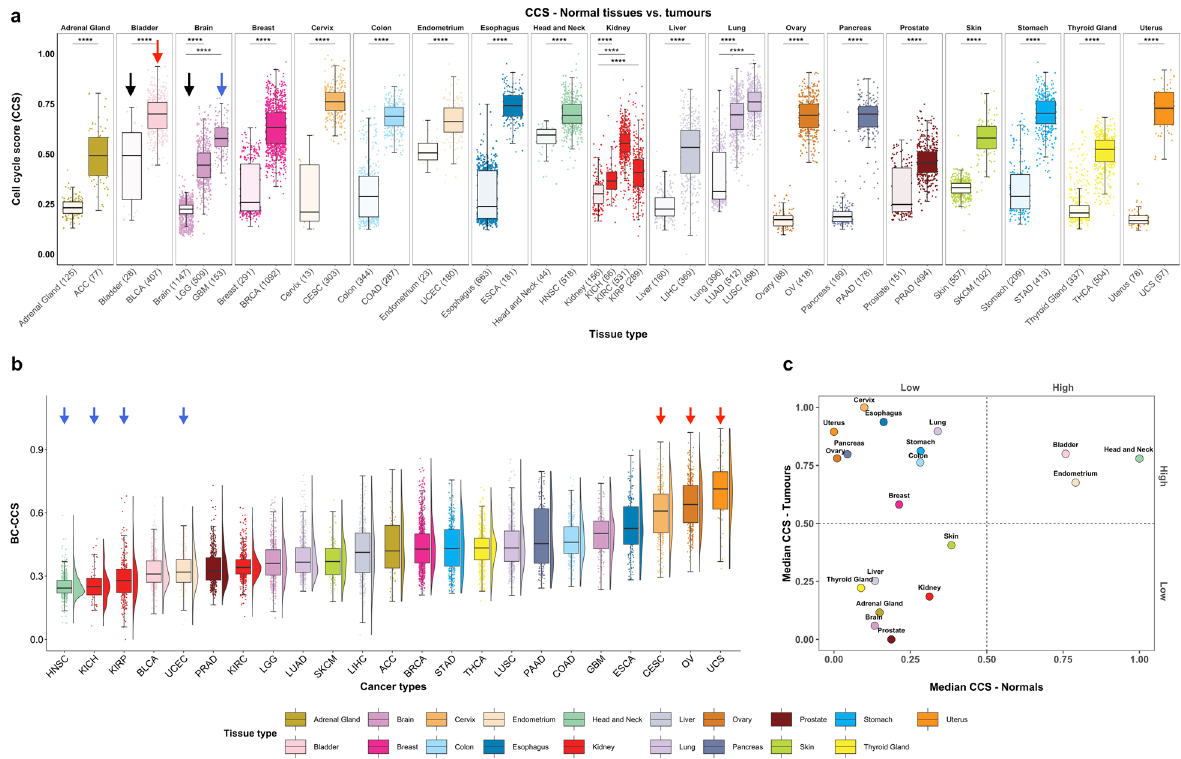
Fig. 3 Boxplots and scatterplot comparing cell cycle activity across normal tissue and Pan-Cancer Atlas tumour samples. Toil pipeline batch corrected mRNA expression data from the GTEx and TCGA pan-cancer datasets were used to examine cell cycle activity. a The CCS gene expression signature was used to create boxplots within in each normal and cancer tissue type, black arrows denote normal bladder and brain tissue, red = BLCA, blue = GBM. b The baseline corrected-CCS (BC-CCS) in pan-cancer tumours, where the median CCS value for the normal tissue of origin has been subtracted from each cancer type. Density plot is placed beside each boxplot. Blue and red arrows indicate cancers from Groups 1 and 2, respectively. c Scatterplot showing the relationship of cell cycle activity in normal tissues with tumour samples on the basis of median CCS expression. Median CCS expression standardised by scaling between 0 and 1. p values in boxplots are based on Student ’ s T-test and corrected for multiple testing; **** = p < 0.0001. Within each box, horizontal lines denote median values; boxes extend from the 25 th to the 75 th percentile of each group ’ s distribution of values; vertical extending lines denote adjacent values (the most extreme values within 1.5 interquartile range of the 25 th to the 75 th percentile of each